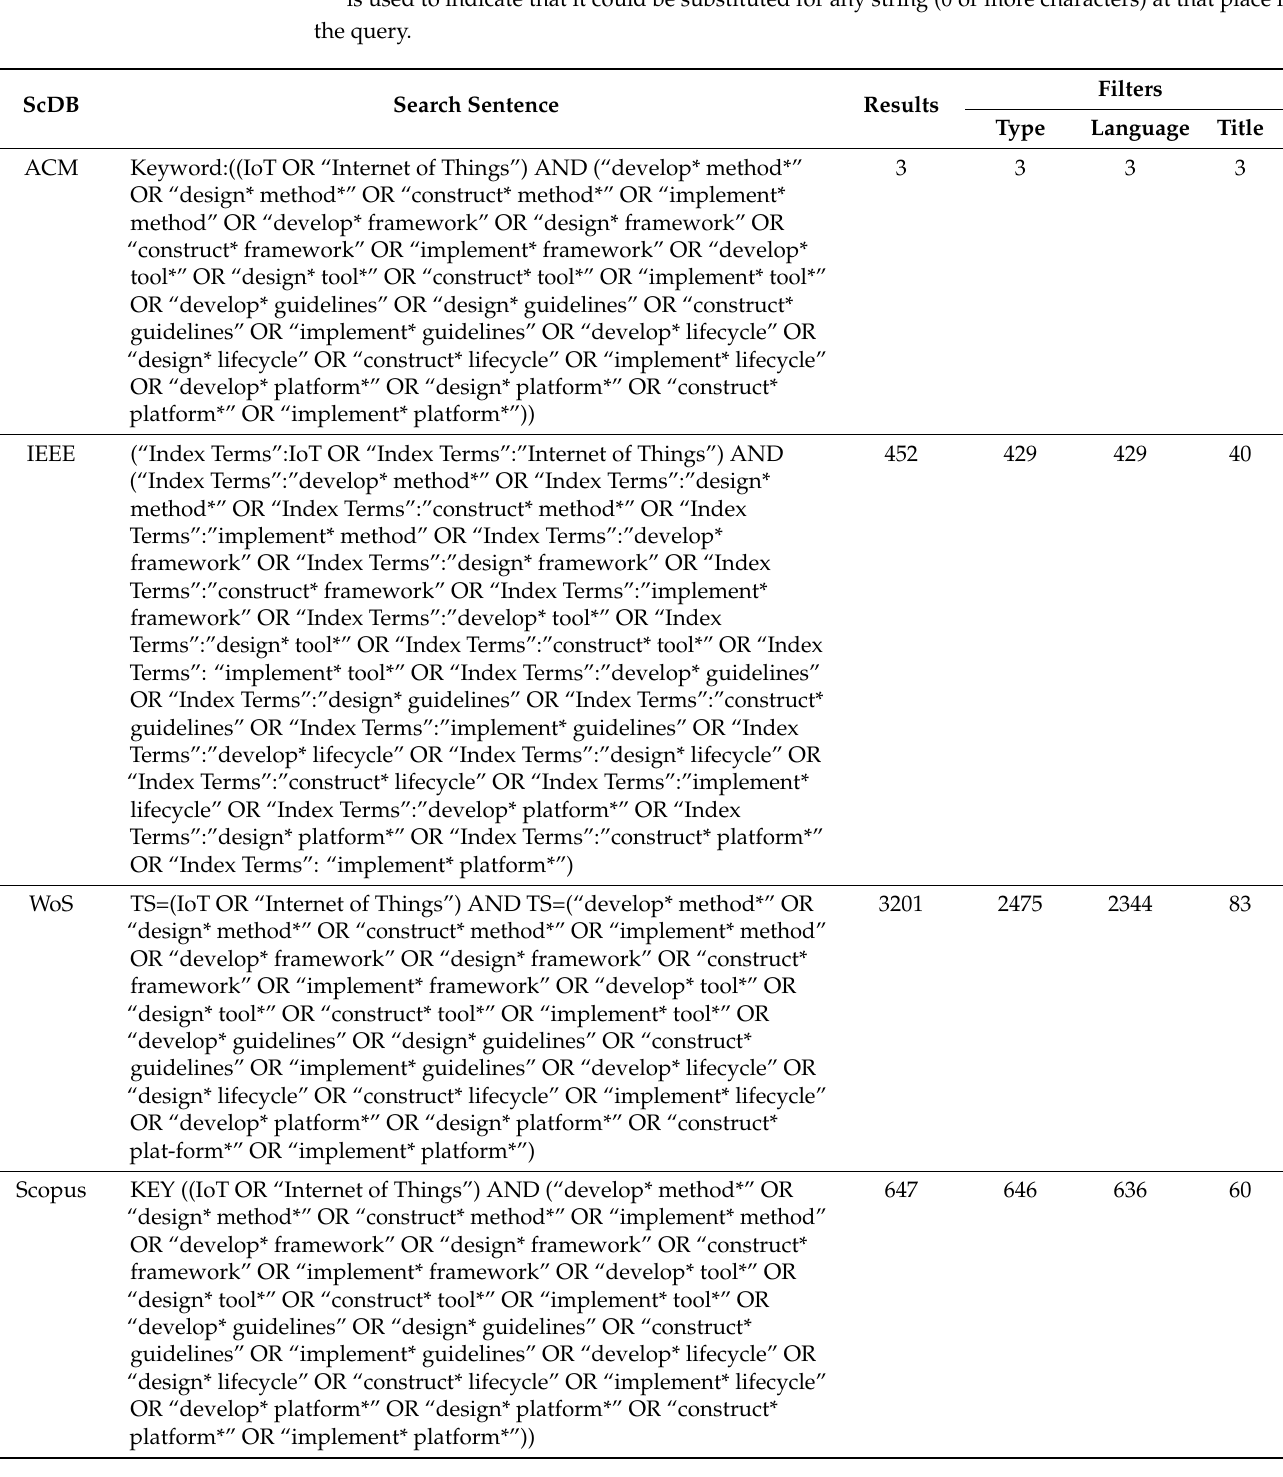
Table 1. Search statements for each ScDB were consulted and a number of results were consulted after executing them and after applying the corresponding filters. As usual, the wildcard character “*” is used to indicate that it could be substituted for any string (0 or more characters) at that place in the